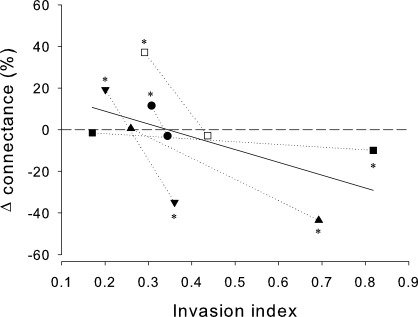
Relation of the Percent Difference in Connectance to Invasion IndexPercent difference represents the connectance of the native plant-pollinator sub-web (CN) relative to the entire web (CC) and was estimated as 100 ·
. Negative and positive connectance differences indicate that native sub-webs are less or more connected than their respective entire webs. We compared the connectances of the native sub-web and the sub-web formed by all other interactions by means of χ
2 test with df = 1. Asterisks indicate significant (p < 0.05) deviations. The solid line represents the best linear fit (y = 21.2 – 61.6x, r
2= 0.300, F = 3.41, df = 1, 8, p = 0.10). N = 10 pollination webs. Symbols as in Figure 1.